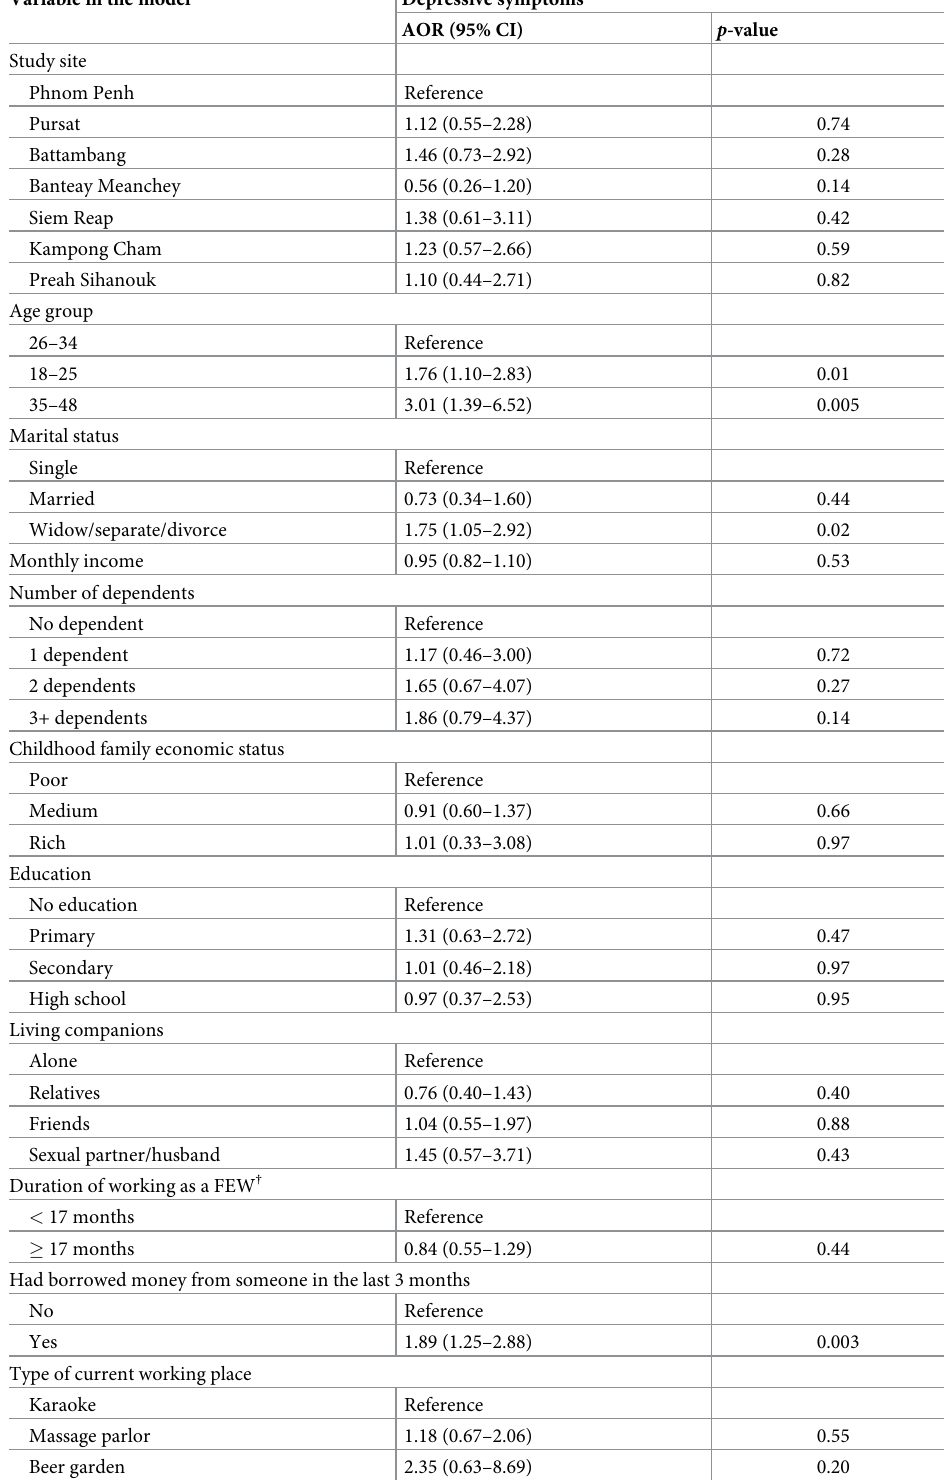
Table 4. Factors associated with depressive symptoms among FEWs ( n =